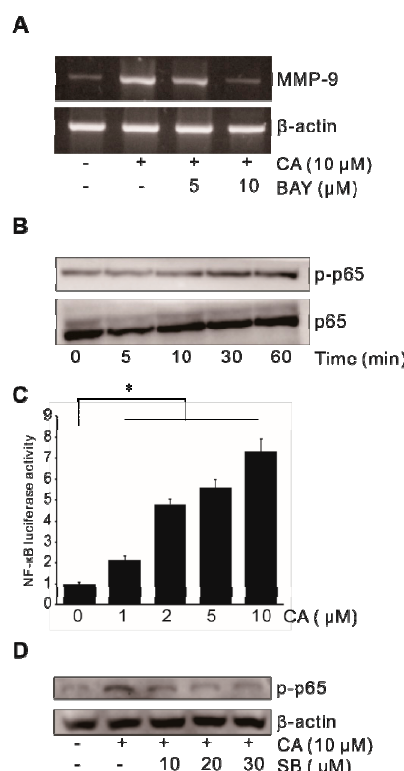
Figure 4. Activation of NF- κ B in CA-induced MMP-9 expression in colon cancer cells. ( A ) SW620 cells pretreated with BAY-11-7082 (BAY) for 1 h were incubated with 10 µ M CA for 6 h, followed by mRNA extraction and RT-PCR to determine MMP-9 expression. ( B ) SW620 cells were treated with 10 µ M CA for 0–60 min and cell lysates were analyzed for total and phosphorylated p65 levels by performing Western blot analysis. ( C ) SW620 cells were transiently transfected with the NF- κ B luciferase reporter construct. Transfected cells were treated with 0–10 µ M CA for 8 h and the luciferase activity was determined using a luminometer. Data represent the mean ± standard deviation (SD) from triplicate measurements. * p < 0.05 versus control. ( D ) SW620 cells pretreated with SB for 1 h were incubated with 10 µ M CA for 1 h and cell lysates were analyzed for phosphorylated p65 levels by performing Western blot analysis.